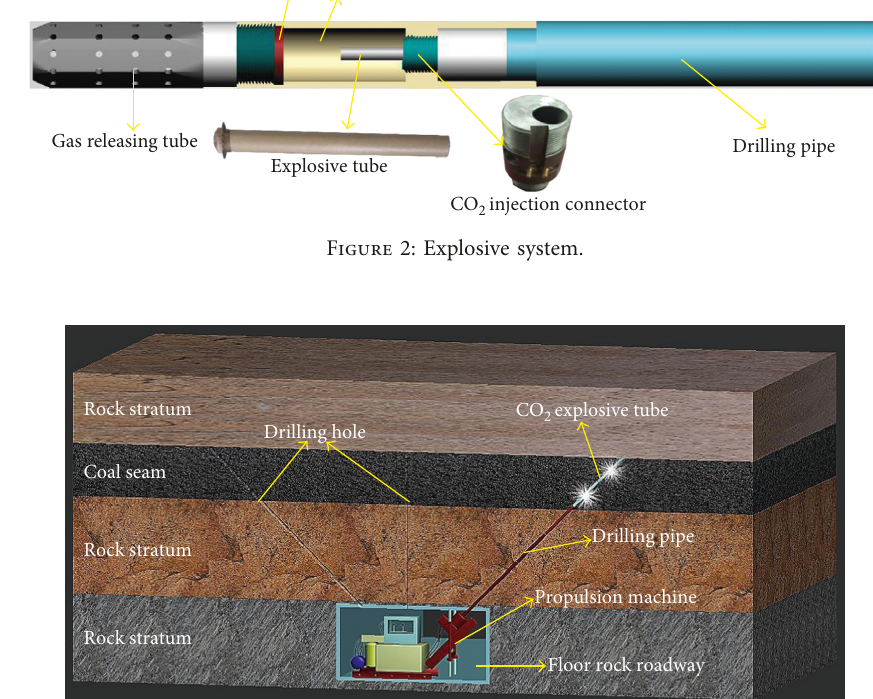
Figure 3: Propulsion system.